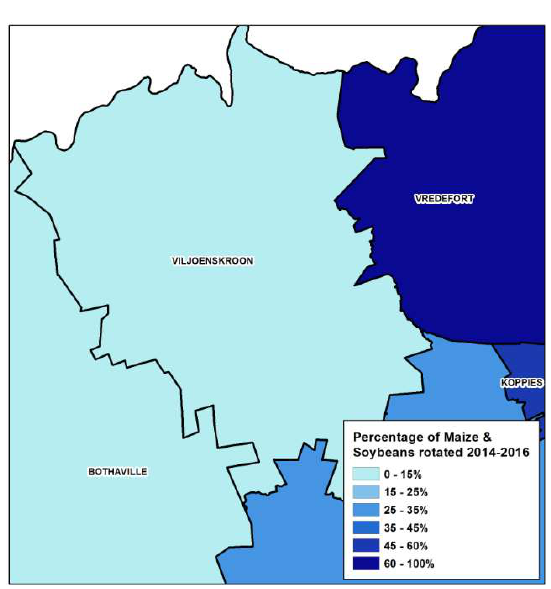
Figure 26. The area Ha rotated between maize and soybeans for the Viljoenskroon and surrounding districts between 2014 and 2016